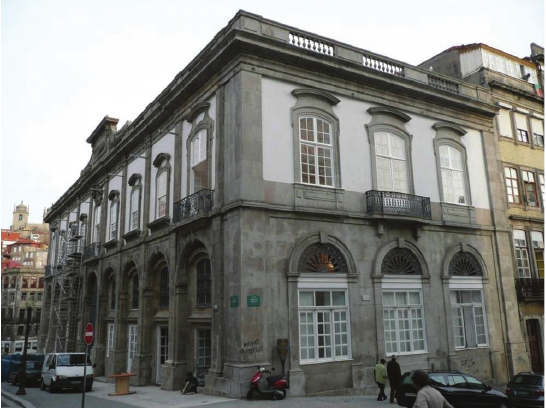
Figure 2: Old porch of the Convent of São Domingos